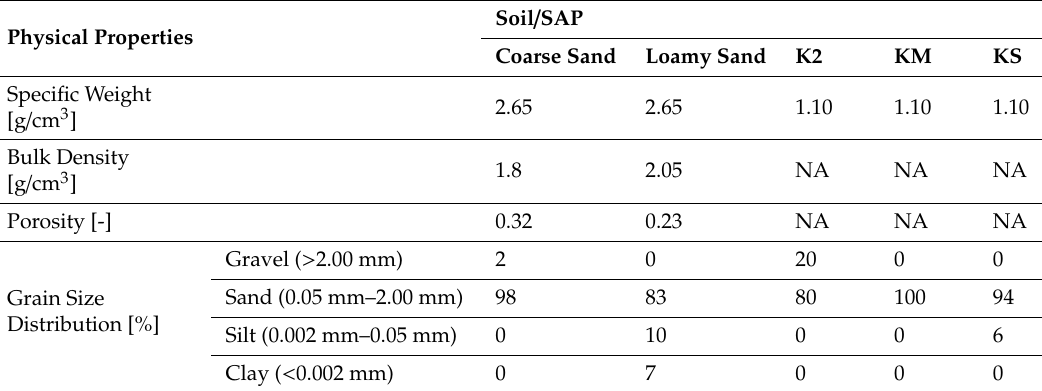
Table 1. Basic physical properties of the used soils and SAPs.